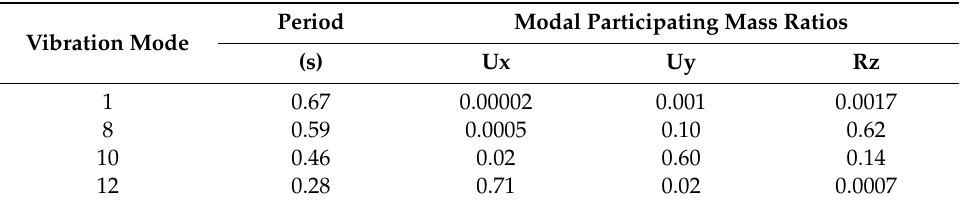
Table 1. Modal parameters of building